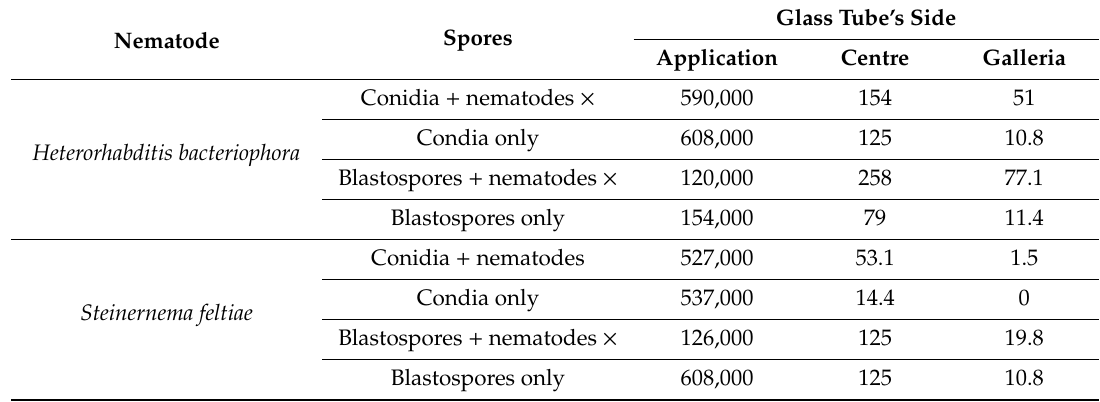
Table 1. Mean number of colony-forming units (CFUs) of Isaria fumosorosea isolated from di ff erent sections of the glass tubes with ensheathed infective juveniles of entomopathogenic nematodes. Statistically significant di ff erences ( p < 0.05) between “conidia or blastospores only” (control) and “conidia or blastospores + nematodes” in Galleria side are marked with asterisks. Dispersal of spores by desheathed nematodes is not shown, as there were almost no CFUs recovered in central and Galleria